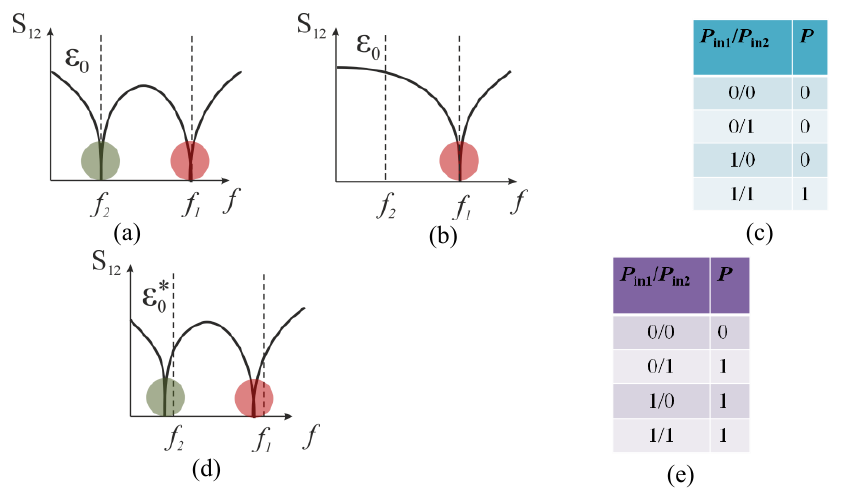
Fig. 2 . (a) Magnetostatic waves spectrum when signal is applied to upper or lower magnonic crystal at dielectric constant ε = ε 0 (b) Magnetostatic waves spectrum when signal is applied to upper and lower magnonic crystal (c) Truth table of AND operator; (d) Magnetostatic waves spectrum when signal is applied to upper or lower magnonic crystal at dielectric constant ε = ε 0* (e) Truth table of OR